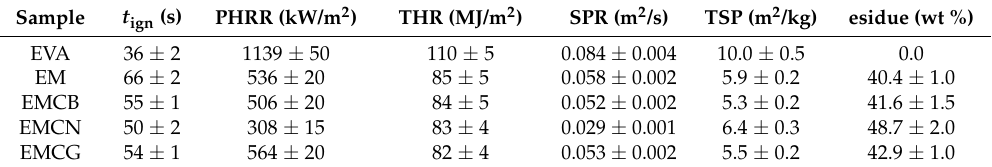
Table 4. Combustion parameters obtained from cone calorimetry test.